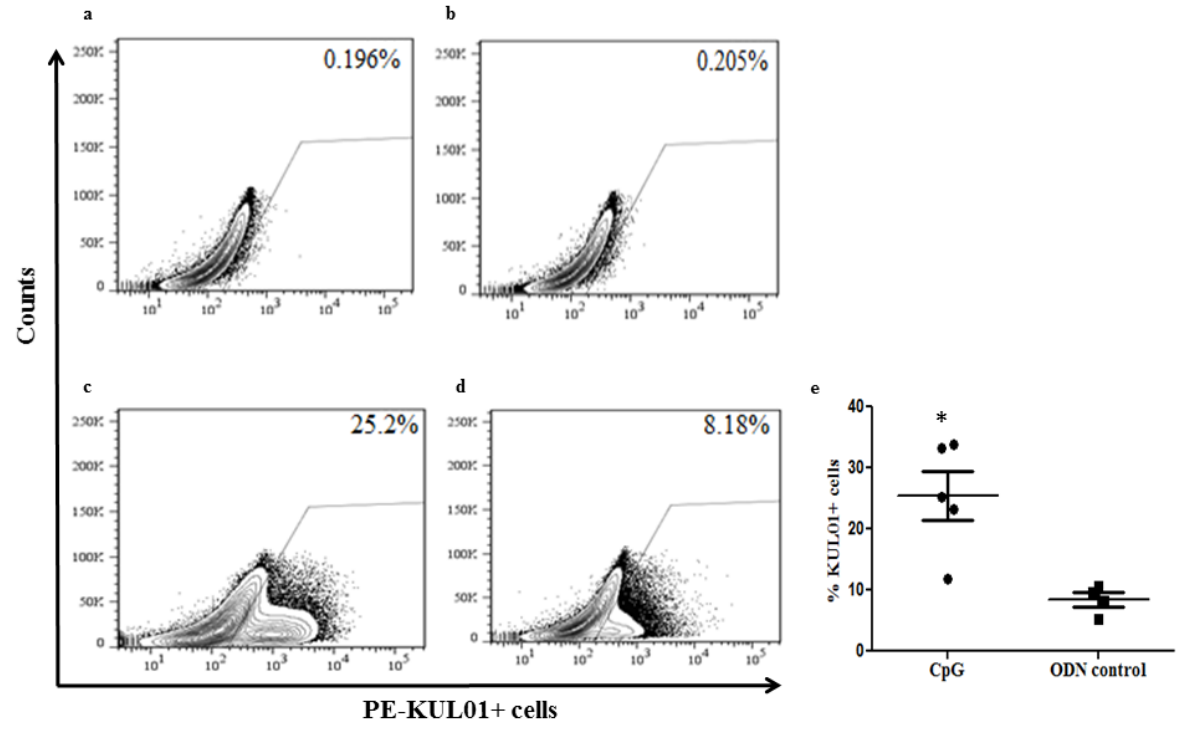
Figure 4. In ovo delivery of CpG DNA expands macrophage numbers in lungs post-hatch. ( a – d ) indicate the representative fluorescence-activated cell sorting diagrams showing unstained control, iso type control, percentage of KUL01+ macrophages in lungs post-hatch originated from in ovo CpG DNA and non-CpG DNA treated groups respectively. ( e ) illustrates the percentage of KUL01+ macrophages in lungs post-hatch originated from in ovo CpG DNA or non-CpG DNA delivered groups. * indicates significant differences between groups at p <